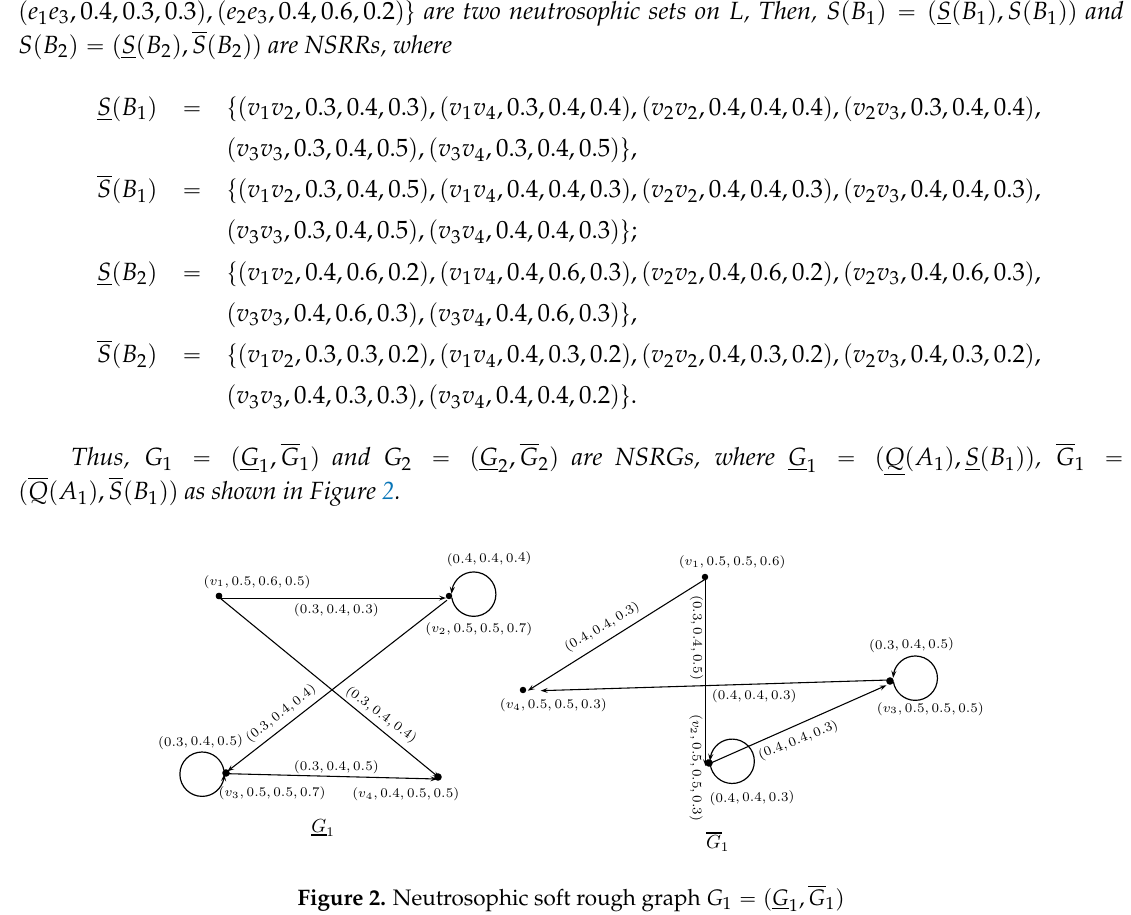
G 1 ∪ G 2 Figure 4: Neutrosophic soft rough graph G 1 ∪ G 2 = ( G 1 ∪ G 2 , G 1 ∪ G 2 ) Definition 2.6. Let G 1 = ( G 1 , G 1 ) and G 2 = ( G 2 , G 2 ) be two NSRGs on V . The intersection of G 1 and G 2 is a neutrosophic soft rough graph G = G 1 ∩ G 2 = ( G 1 ∩ G 2 , G 1 ∩ G 2 ), where G 1 ∩ G 2 = 9